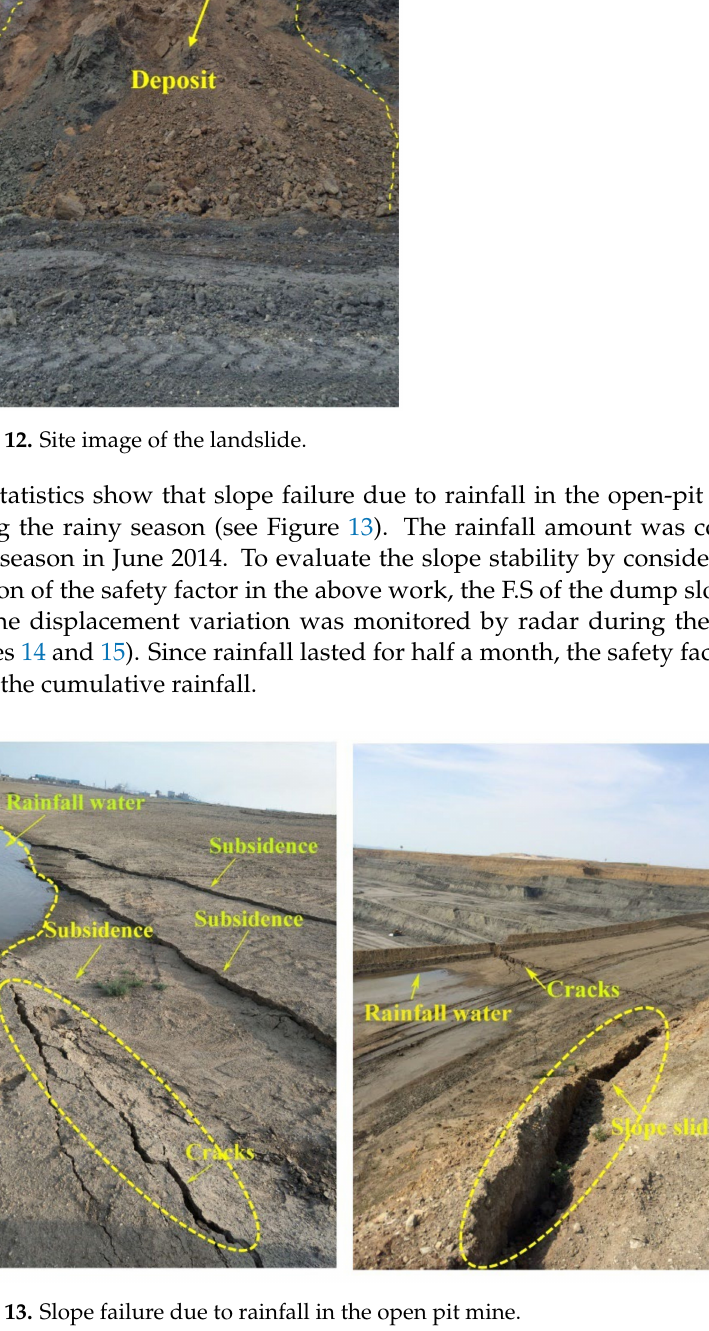
Figure 13. Slope failure due to rainfall in the open pit